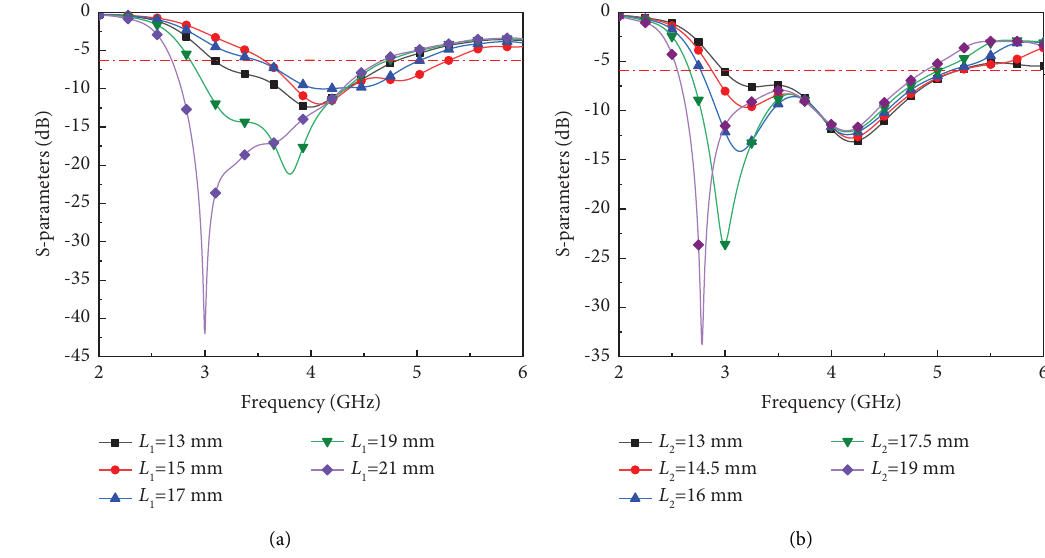
Figure 4: Simulated S -parameters ( S 11 ) with diferent values of (a) L 1 and (b) L 2 .